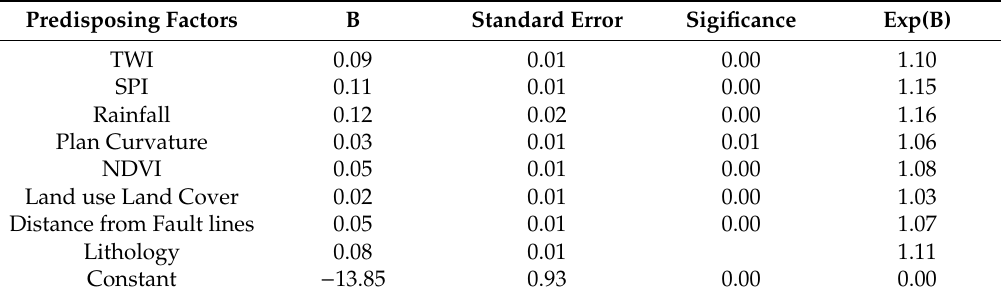
Table 6. Results of Logistic